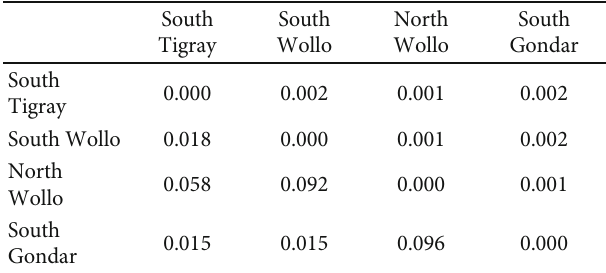
Table 5: Pairwise F values between geographic origins of O. ST crenata populations.